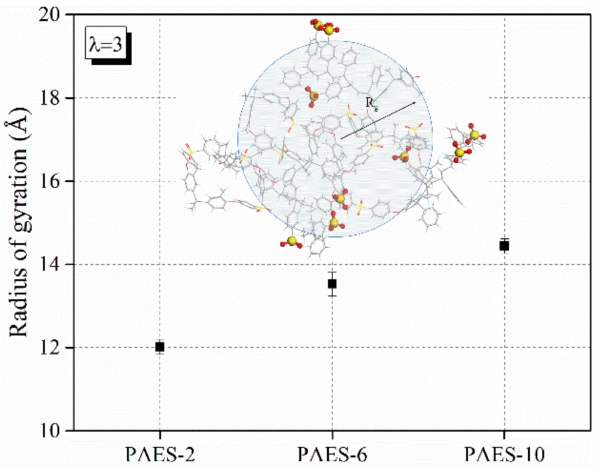
Figure 8. The radius of gyration of the SPAES polymers.